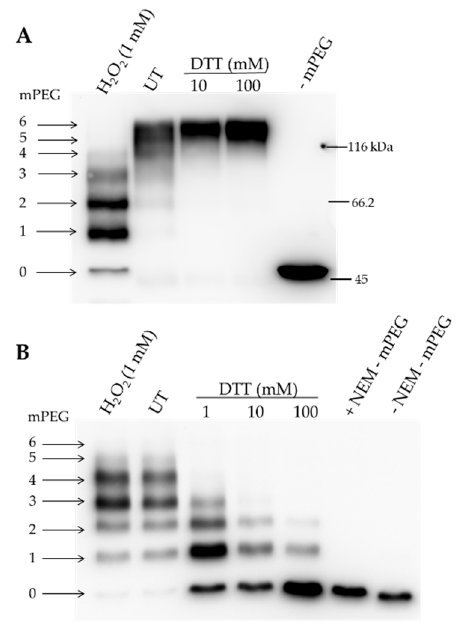
Figure 5. Labeling of the recombinant His-tagged ALAD containing six cysteines by using methoxypolyethylene glycol maleimide (mPEG-MAL)-5000. ( A ) mPEG-MAL labeling after pretreatment of ALAD in oxidizing (CuCl 2 /hydrogen peroxide) or reducing conditions (DTT). The accessibility of the reduced cysteines in mature ALAD depended on this pretreatment. Each binding of a mPEG-MAL-5000 molecule to a cysteine induced a characteristic mobility shift in an 8% SDS-PAGE. The arrows numbered 0–6 indicate the unlabeled (0) and labeled ALAD (1–6). ( B ) Labeling of the oxidized and buried cysteines. After the pretreatment with oxidizing and reducing agents, all exposed cysteines were blocked irreversibly with N-ethylmaleimide (NEM). Subsequently, all samples were reduced with DTT (100 mM) and subsequently labeled with mPEG-MAL-5000. UT: